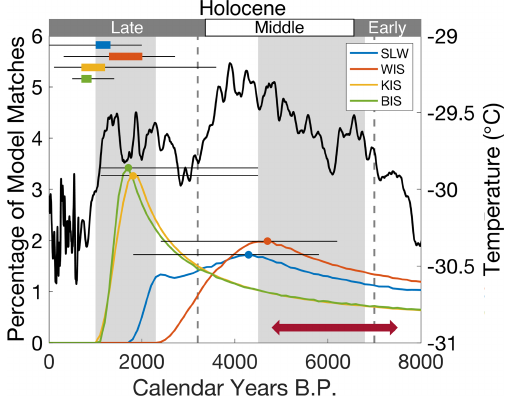
Figure 8. The estimated timing of grounding line retreat and read- vance compared to selected climate data for the study region. The colored lines (which correspond to the left y axis) represent the probability distribution of the timing of grounding line retreat ( T o + T i ) for each subglacial field site. The lines are calculated by summing T o and T i from the model matches in between the dashed lines of the radiocarbon model results shown in Fig. 7. The dots on the peaks of the distributions indicate the optimal timing of ground- ing line retreat, and the thin black lines indicate the estimate on error. The box-and-whisker plots in the upper left corner indicate the timing of grounding line readvance over our field sites ( T i ) es- timated from temperature and ionic diffusion modeling. The thick black line (which corresponds to the right y axis) represents the Holocene history of surface temperature at WAIS Divide (Cuffey et al., 2016; Cuffey, 2017). The gray vertical shaded regions indicate the warm periods of less extensive sea ice in the western Ross Sea proposed by Hall et al. (2006), and the gray dashed lines bracket the period of Ross Sea warming identified by Cunningham et al. (1999). The maroon arrow indicates the estimated range of grounding line retreat over WGZ based on the ramped-pyrolysis method (Venturelli et al.,